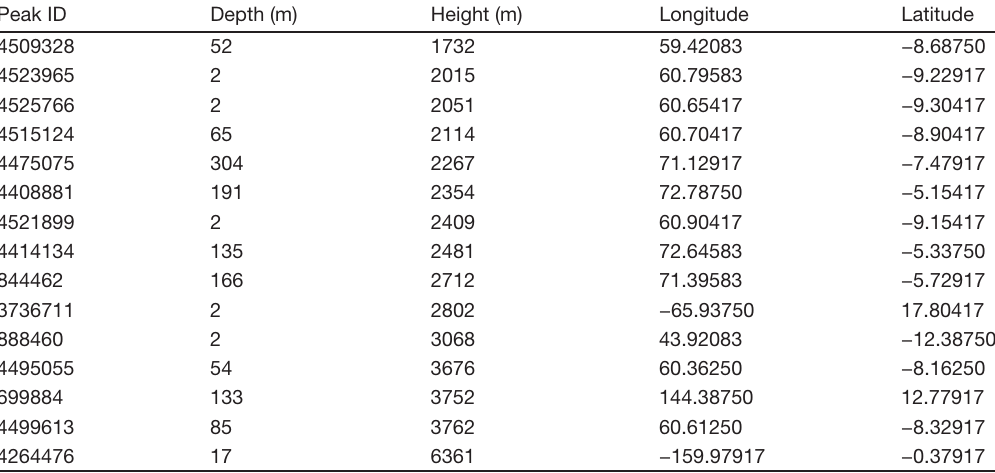
Table 1. List of ‘phantom seamounts’ where inferred seamounts appear coincide with sites of no bottom soundings Peak ID Depth